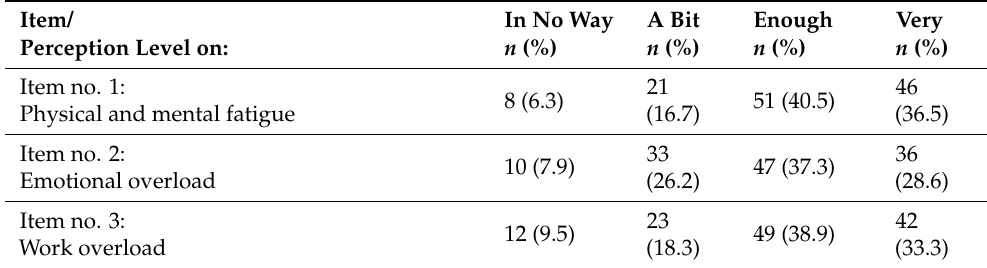
Table 2. Nurses’ perceptions on their work environments during the COVID-19